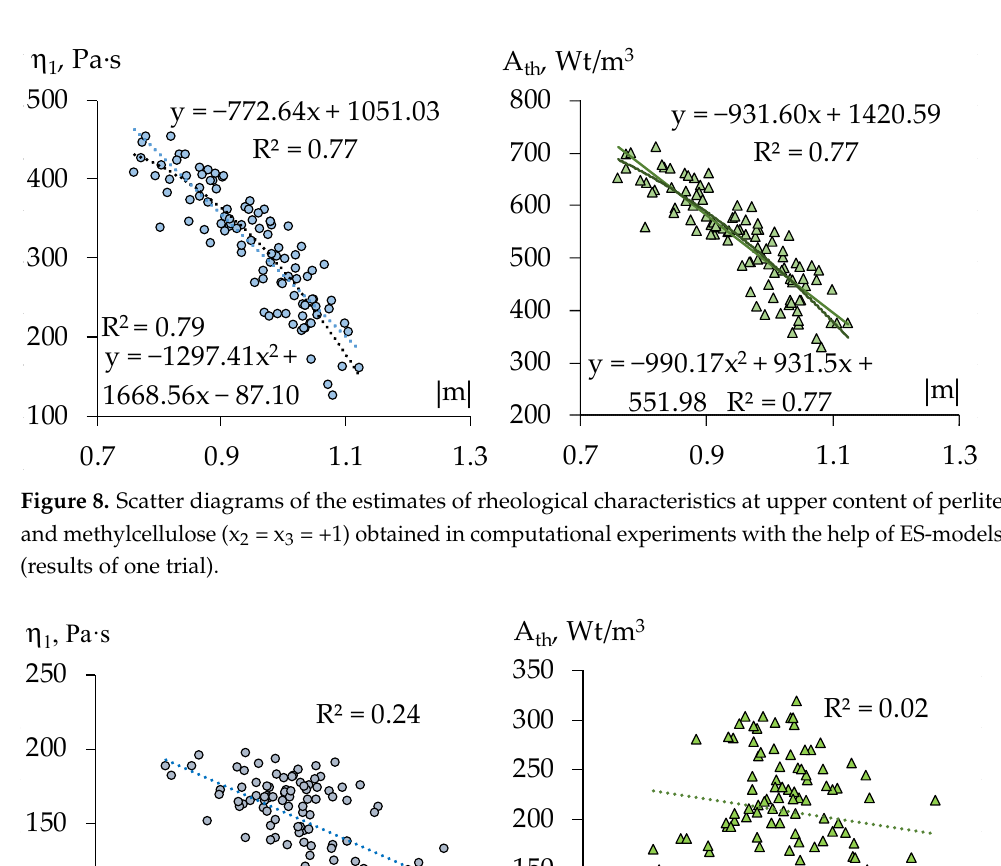
12 of 16 Figure 7. Scatter diagrams of viscosity at shear rate equal unity (K in Ostvald-de-Waele model), of thixotropy, and destruction rate of the 18 compositions (results of natural experiment). The information that would allow the existence of correlation and distinctions in re- lations between |m| and A th in various formulation zones to be revealed and character- ized can be obtained in computational experiments, in which the statistical trials (with Monte Carlo method [50,51]) are carried out [30,52]. The paired samples of any size (n) necessary for the analysis and for building possible prediction equations can be simulated with the help of the ES-models obtained. In each realization of the trial, the sufficiently great number of compositions (x) uniformly distributed in the whole formulation region under study or in its subregion are generated. For each x the generated normally distrib- uted experimental error is added to the level of the property (Y) calculated by correspond- ing ES-model. By n pairs of these values the point estimate of coefficient r (or other meas- ure of correlation) is obtained. Multiple realization of such trials makes it possible to get the distribution and interval estimate of r. The procedure briefly described above was used in computational experiments, in various zones of the factor region, when the upper or lower levels of one or two factors were fixed (substituted in the models). Specifically, each diagram in Figures 8 and 9 represents 100 pairs of values, (|m|, K)